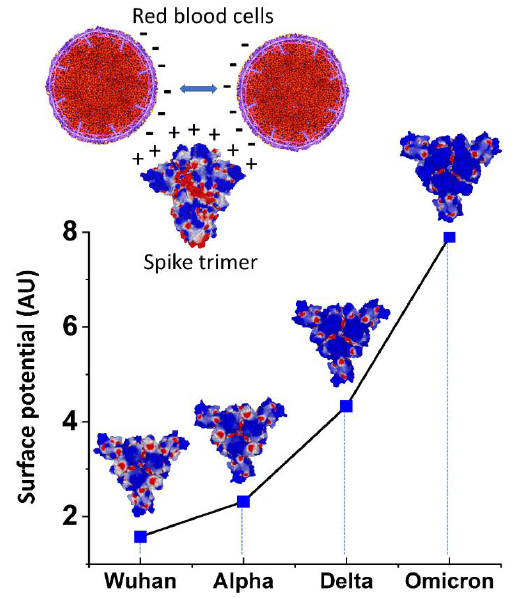
Figure 5. Electrostatic surface potential of SARS-CoV-2 spike trimers as denoted by color, positive in blue and negative in red. Upper panel . Under physiological conditions, RBCs maintain separation from each other due to a repulsive electric zeta potential between their negatively charged surfaces. The electropositive surface of spike protein neutralizes this zeta potential, allowing closer contacts between RBCs. Lower panel . For all variants, the electrostatic surface potential of the spike trimer is more electropositive in the central area formed by the RBD of each monomer. Quantitative analysis of the surface potential (in AU = arbitrary units) shows an exponential increase from the Wuhan to Omicron lineages.